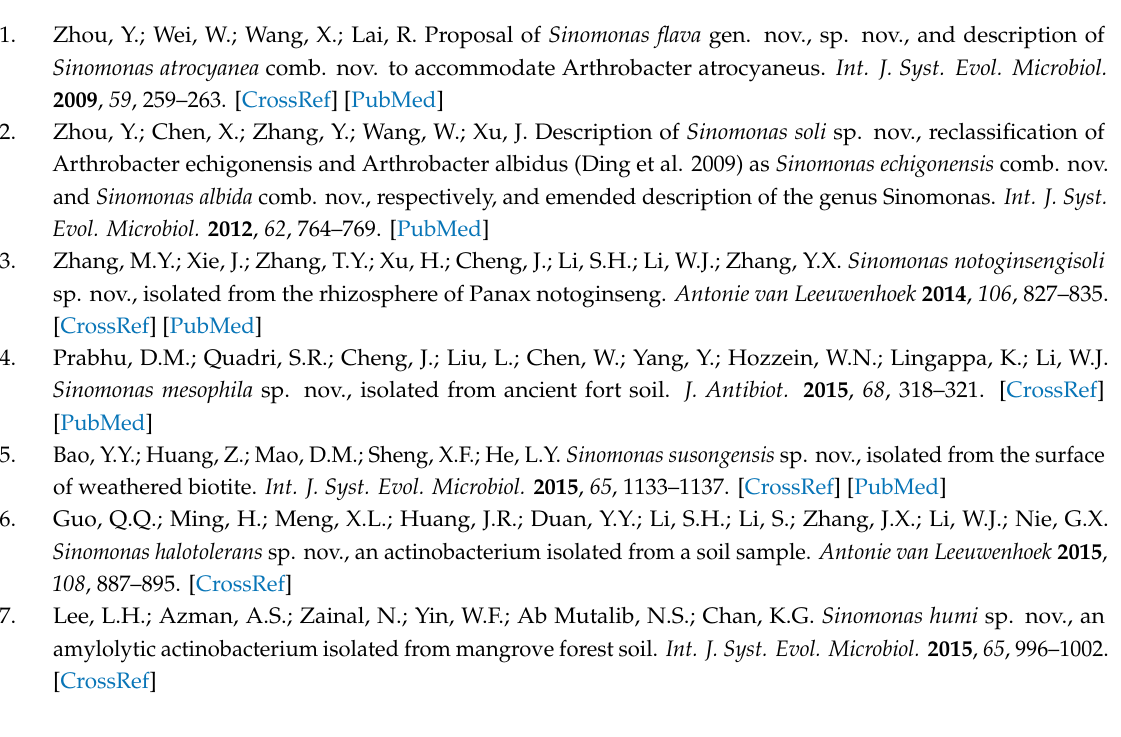
Figure S1: Maximum likelihood tree based on 16S rRNA gene sequences showing relationship between strain NEAU-HV1 T and related taxa. Only bootstrap values above 50% (percentages of 1000 replications) are indicated. Bar, 0.02 nucleotide substitutions per site, Figure S2: Minimum evolution tree based on 16S rRNA gene sequences showing relationship between strain NEAU-HV1 T and related taxa. Only bootstrap values above 50% (percentages of 1000 replications) are indicated, Figure S3: The polar lipids of strain NEAU-HV1 T after two-dimensional TLC and sprayed with molybdophosphoric acid. a, using molybdenum blue reagent; b, using ninhydrin reagent; c, using anisaldehyde reagent, d, using molybdophosphoric acid reagent. Diphosphatidylglycerol (DPG), phosphatidylglycerol (PG), phosphatidylinositol (PI) and glycolipids 1–4 (GL1–4), Table S1: Di ff